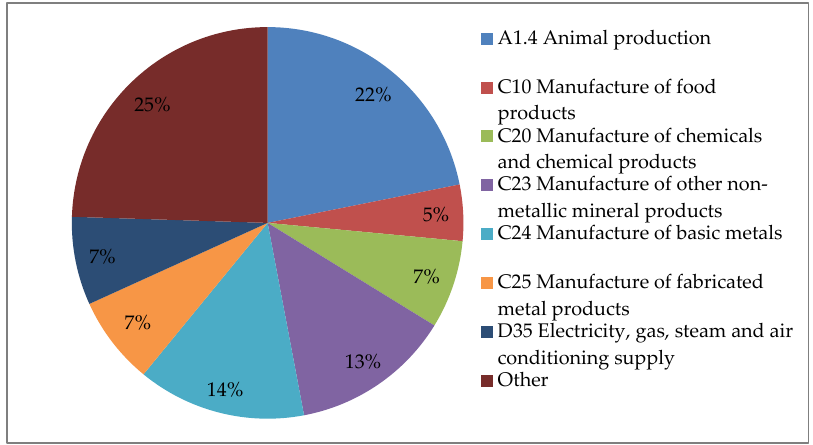
Figure 6. Bulgarian participants type profile.